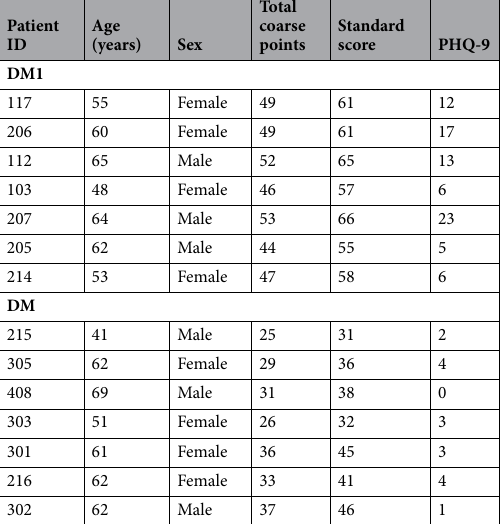
Table 1. SDS and PHQ9 scores in the DM1 and DM groups.